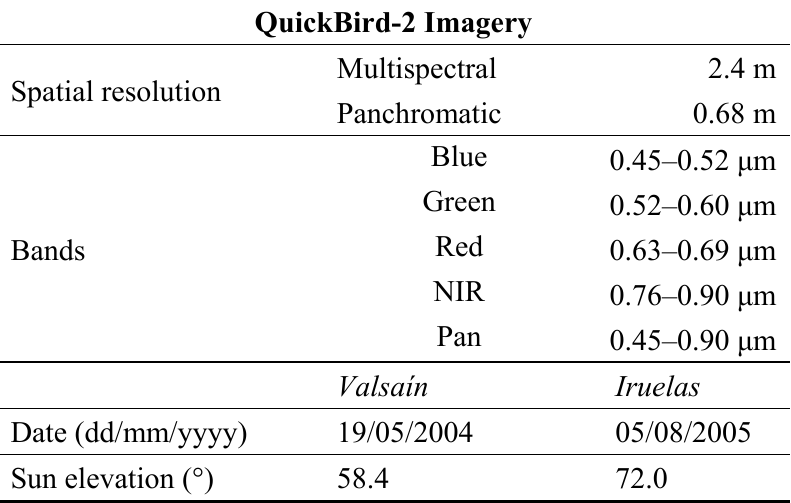
Table 2. Characteristics of the satellite imagery used in the